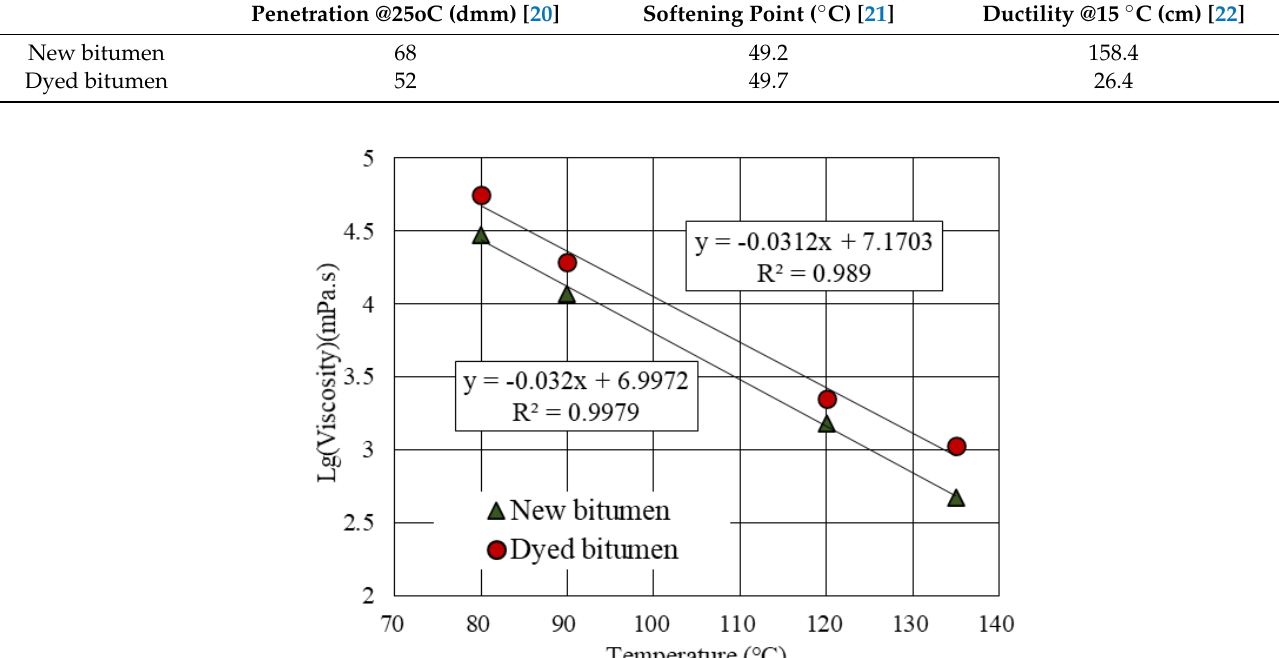
Figure 2. Viscosity-temperature curves for new bitumen and dyed bitumen.